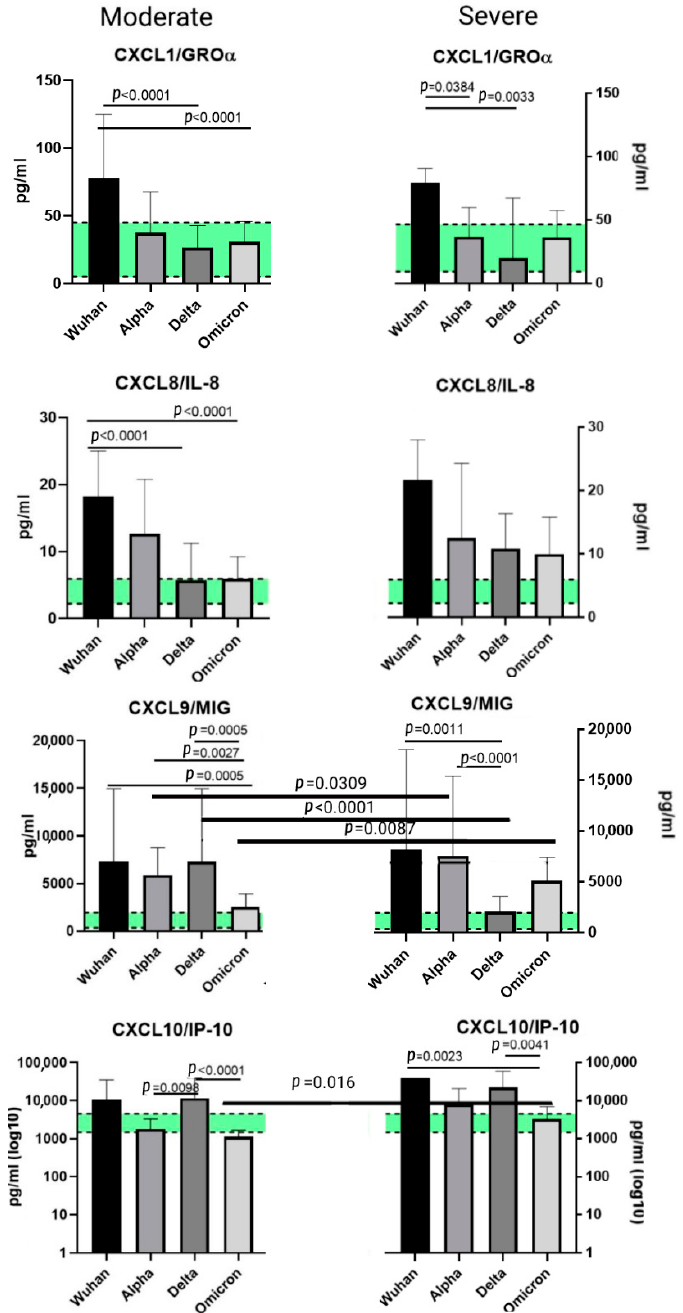
Figure 6. A comparison of the concentrations of C-X-C chemokines in patients with Wuhan, Alpha, Delta, and Omicron strains, depending on severity. The concentrations are presented in pg/mL (median and interquartile range). For CXCL10/IP-10, the concentration axis (Y) is presented as a logarithmic (log10). The green stripe represents Q25–Q75 of the chemokine concentrations in the samples from healthy donors.